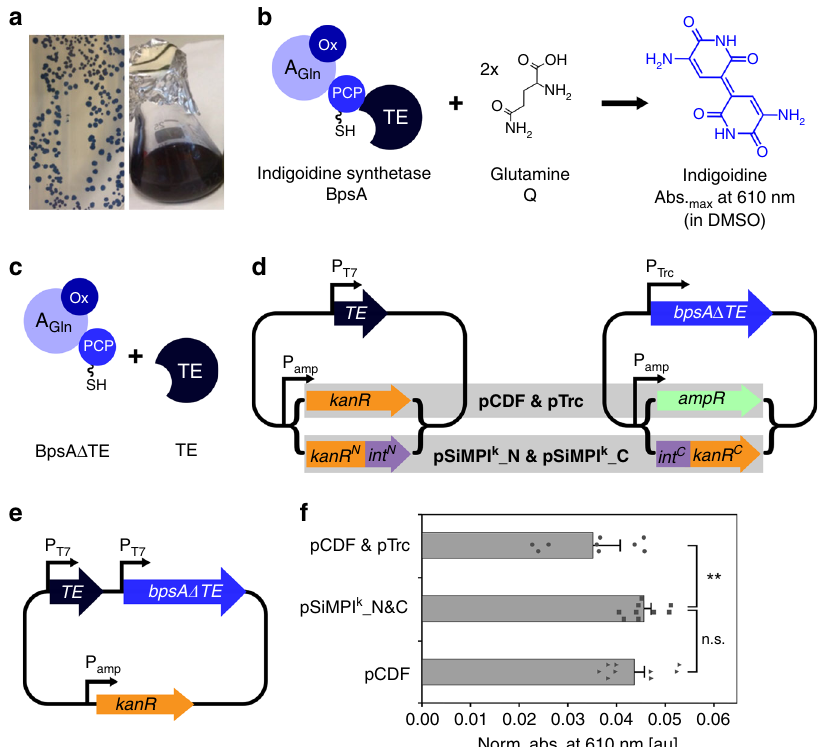
Fig. 6 SiMPl plasmids increase production of the non-ribosomal peptide indigoidine. a Images of BAP1 cells producing indigoidine on plate (left) and in liquid culture (right). b Schematic of indigoidine biosynthesis. A Gln , Adenylation (A) domain speci fi c for glutamine; Ox, oxidation domain embedded within the A domain; PCP, peptidyl carrier protein domain. The PCP domain is depicted with the PPant arm attached to it; TE, thioesterase domain. c Schematic representation of the truncated BpsA (BpsA Δ TE) and the externally supplied TE domain used in this study. d , e Schematic of the plasmids used in ( f ). f Bar graph showing the absorbance at 610 nm of overnight expression cultures in 85% DMSO of BAP1 cells expressing the indicated constructs from the indicated plasmids induced with 100 μ M IPTG at 18 °C. Values were normalized to the value of the control (full-length BpsA expressed from pTrc99a) and represent mean (± standard error of the mean) of three biological replicates. ns, not signi fi cant (two-tailed, homoscedastic Student ’ s t test).; double asterisk (**), p-value < 0.01 (two-tailed, heteroscedastic Student ’ s t test). pCDF, plasmid shown in ( e ). Source data are provided as a Source Data fi